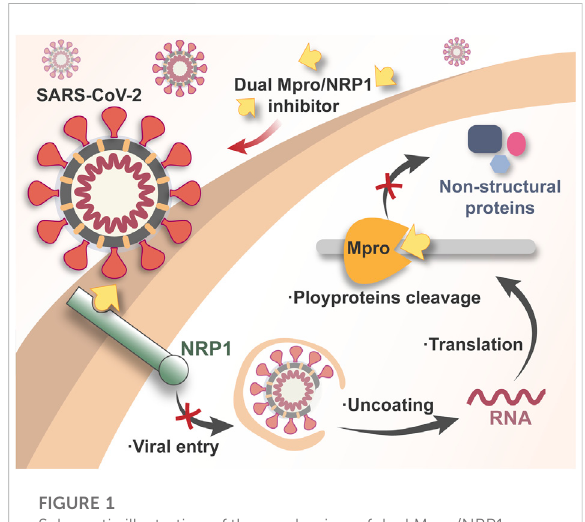
FIGURE 1 Schematic illustration of the mechanism of dual Mpro/NRP1- targeting inhibitors against